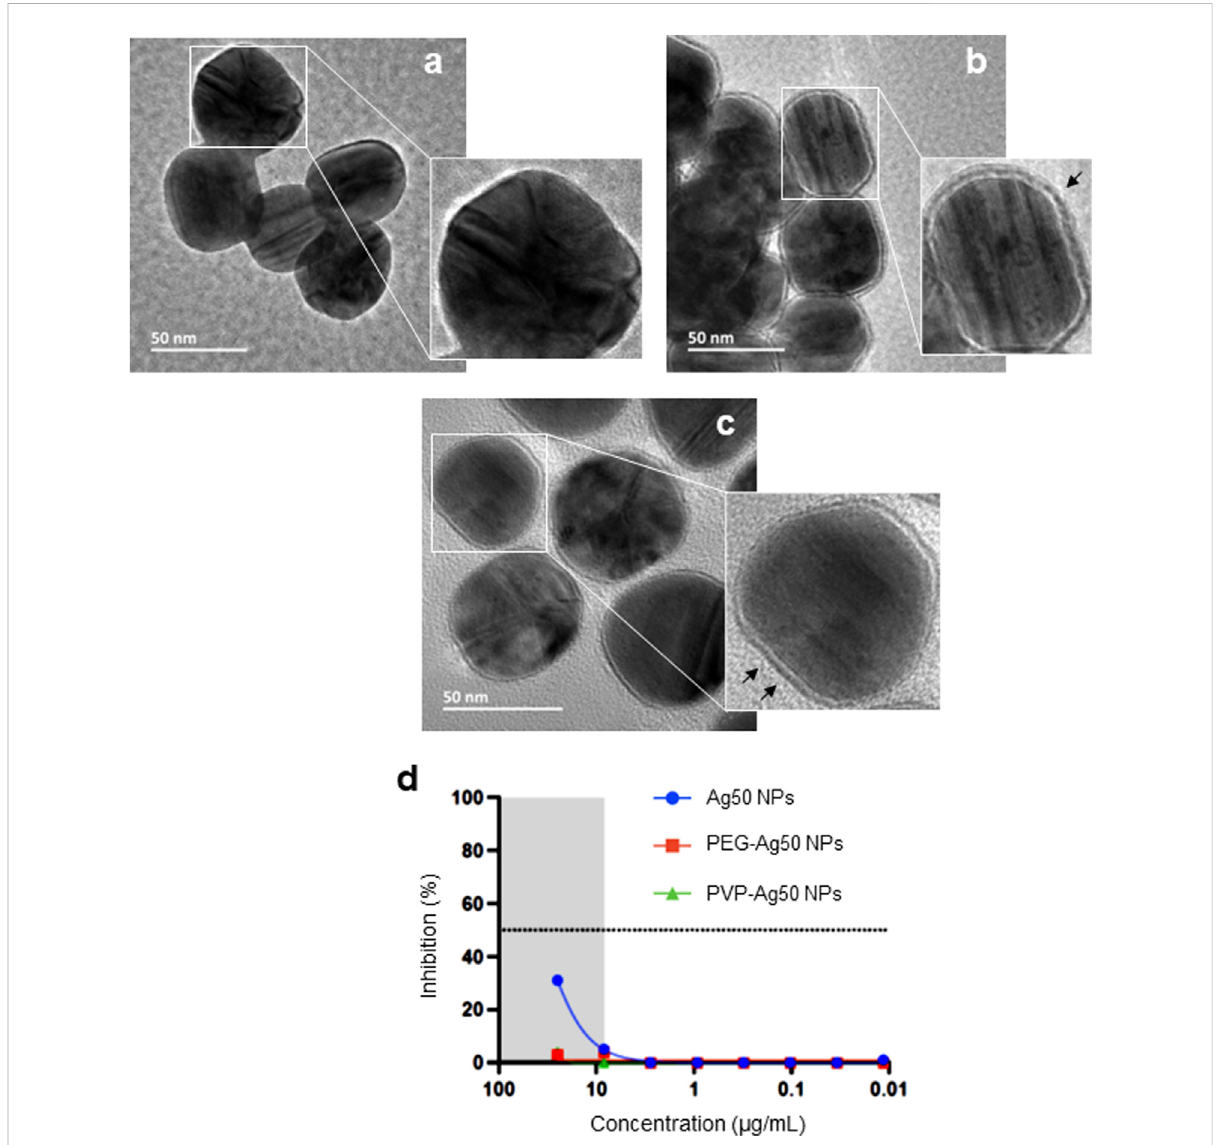
FIGURE 2 Surface coating impacts on anti-viral activity of Ag NPs. HR-TEM micrographs of (A) bare-Ag50 NPs (citrate-stabilized), (B) PVP-coated Ag50 NPs, and (C) PEG-coated Ag50 NPs. The black arrows in (B,C) denote the surface coating. (D) Inhibition of pseudovirus infection in the human lung cell model H1299-ACE2-TMPRSS2 cells after pre-incubation (1 h) with bare versus PVP- or PEG-coated Ag